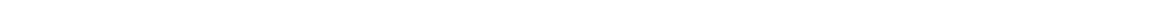
Fig. 3 Circular permutation and glycan-masking of BG505 MD39 trimer. a gp140 trimer gene layout for standard native-like trimers (labeled gp140) and for circular permuted trimers (labeled gp140-cp). The trimer is shown in surface representation, subunits are colored green, blue and light pink. A model of the designed loop is shown in orange spheres. b A structural model of BG505 MD39 GRSF6. The trimer is colored as in a . Native glycans are shown in red spheres, and designed glycans are shown in yellow spheres. Each designed glycan is labeled in HXB2 numbering c Negative-stain EM 3D reconstruction of the base-binding monoclonal 12N Fab (blue) in complex with BG505 SOSIPv4.1 (grey). d The ELISA data for monoclonal rabbit antibody, 12N, binding to trimer variants. e ELISA assay format for testing VRC01 gH mouse sera. f ELISA AUC data for sera from six VRC01 gH mice binding to various trimers. ELISA antigens labeled on the x -axis and mouse identi fi ers in the legend. The Area Under the Curve has units of absorbance×log(dilution). g ELISA assay format for testing rhesus macaque sera. h The ELISA AUC data for sera from six BG505 Olio6-immunized rhesus macaques binding to various trimers. ELISA antigen is BG505 MD39, the competitors are listed on the x -axis, and the monkey identi fi ers are given in the legend. All trimers were made in 293F cells, unless otherwise noted. Measurements are done in duplicate and represent two independent